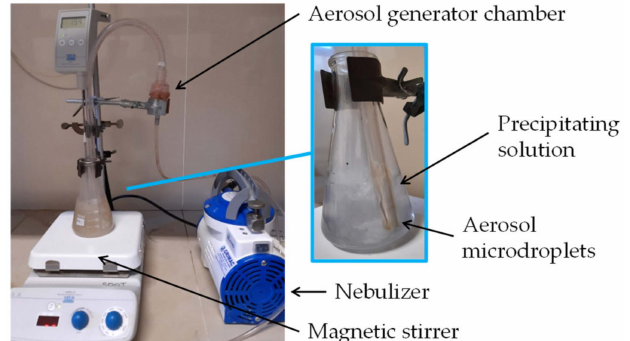
Figure 9. Equipment used to generate microdroplets, in which Ce or Co solutions are atomized in the nebulizer chamber and transported with a flow of air to the precipitating solution, which is vigorously